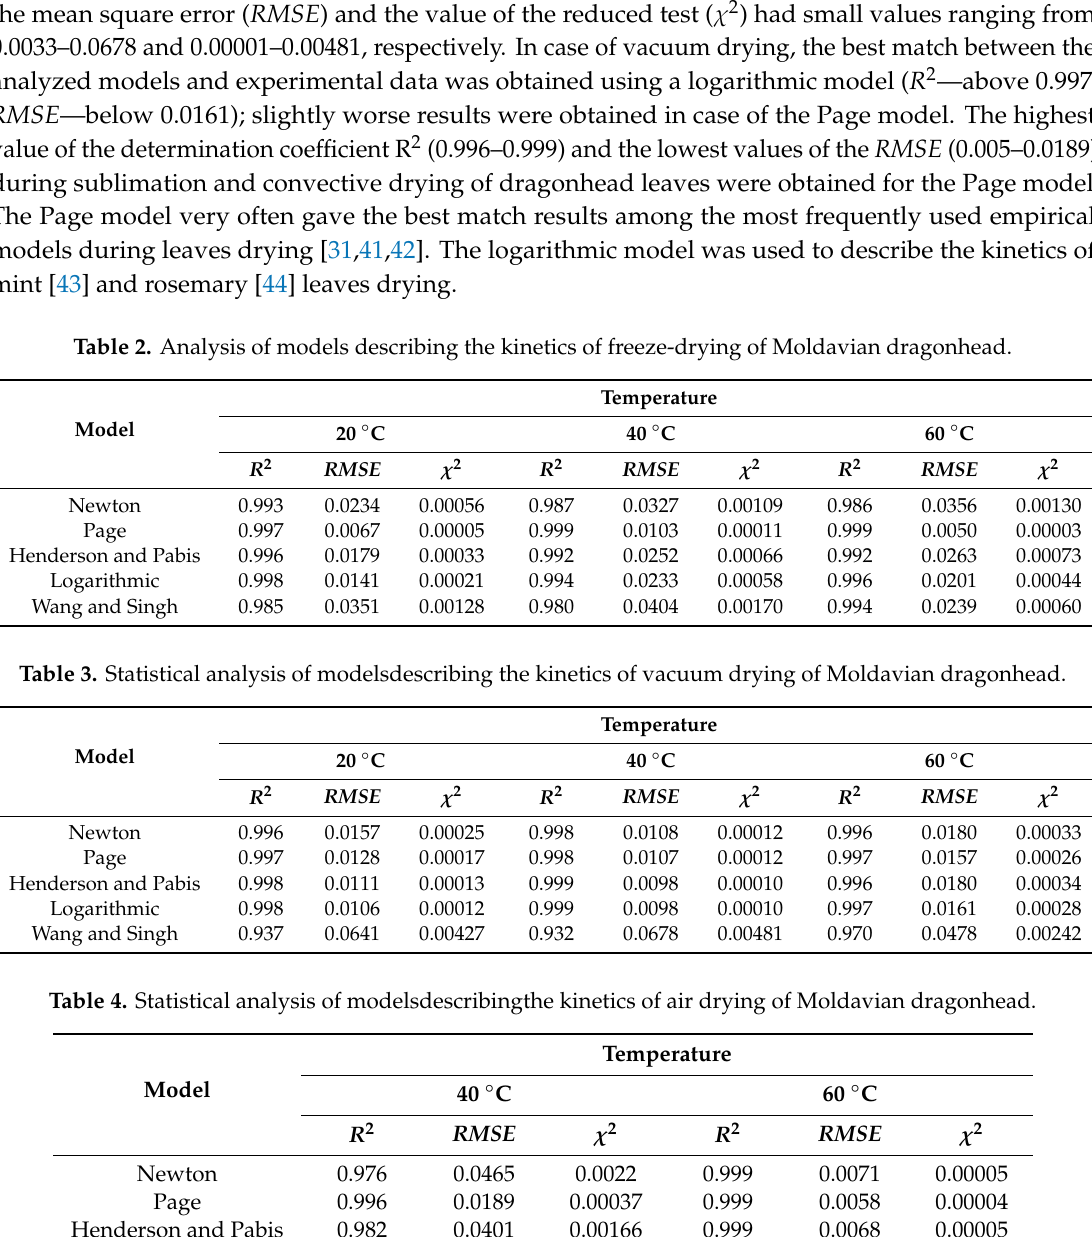
Table 2. Analysis of models describing the kinetics of freeze-drying of Moldavian dragonhead.